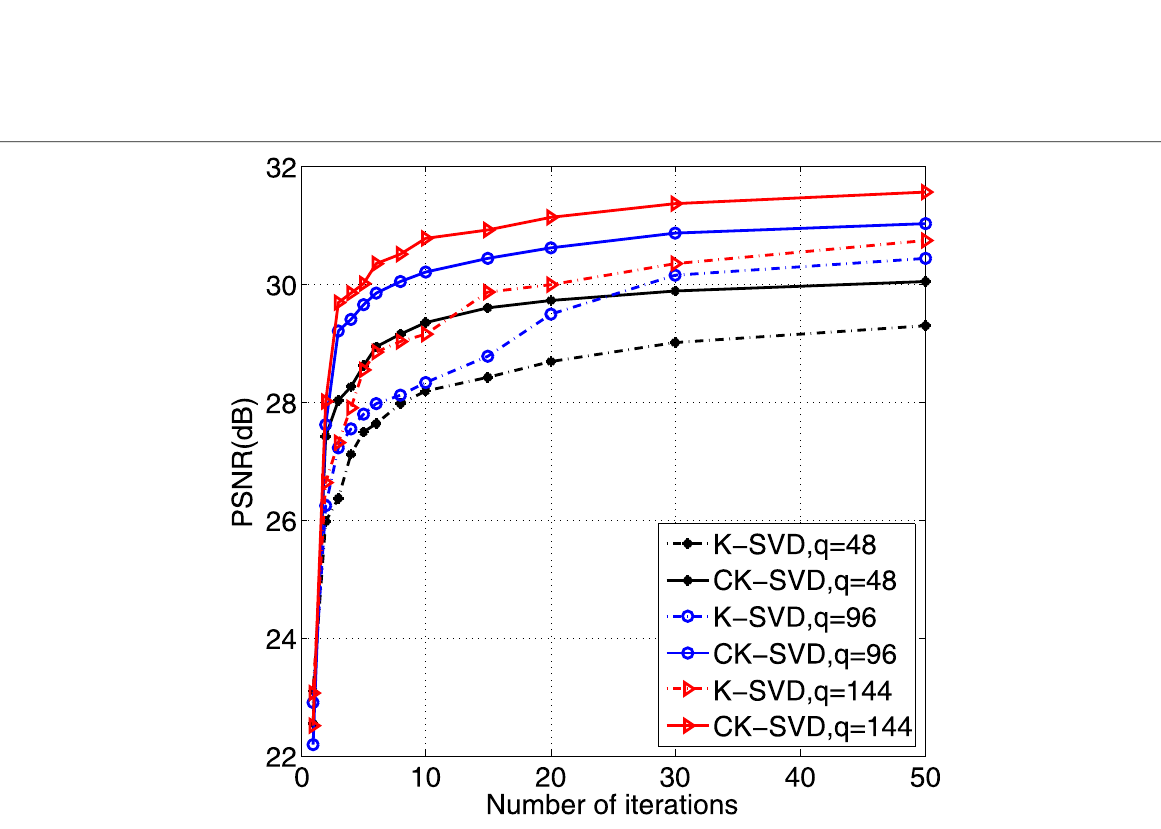
Fig. 6 PSNR of the sparse representations of test images versus the number of iterations, k =